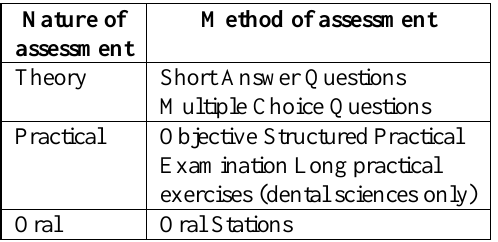
Table IV : Assessment